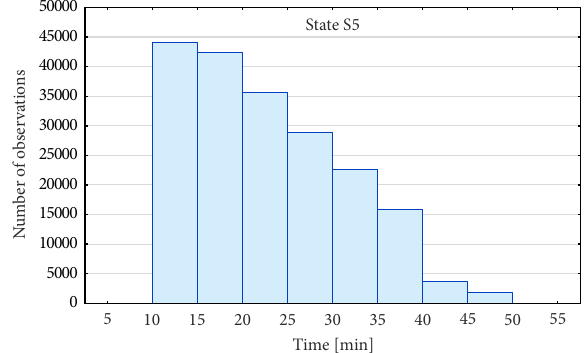
Figure 1. Distribution of time spent in the current